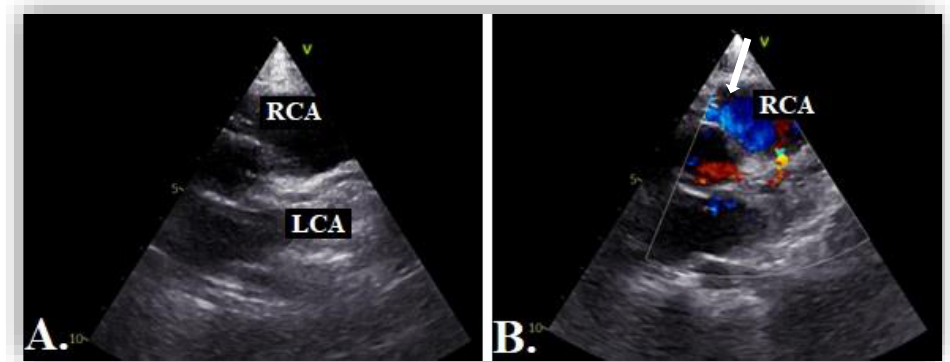
Figure 8. Transthoracic echocardiography in parasternal short axis view showing 2D image ( A ) and color Doppler imaging ( B ) of the right coronary artery, RCA (blue flow, white arrow).